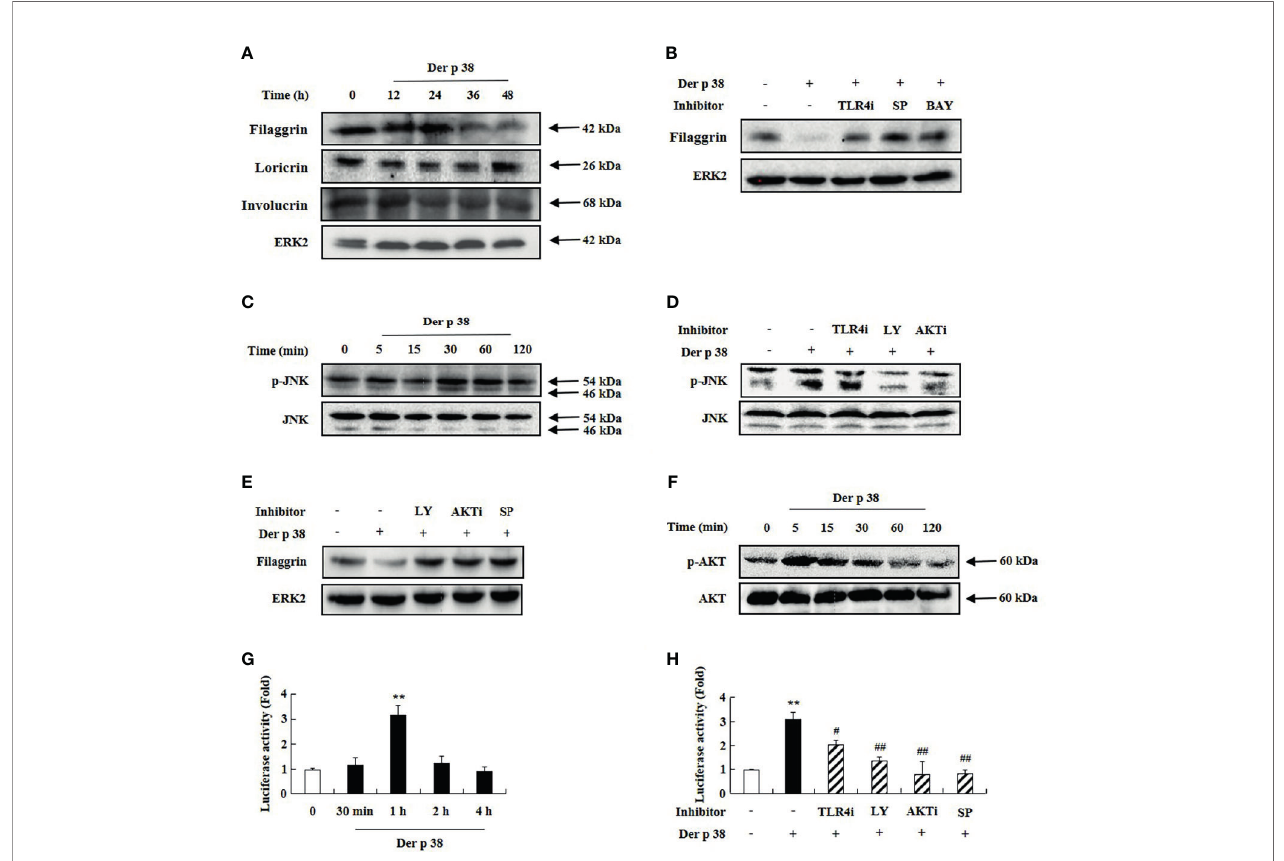
FIGURE 2 | Der p 38 diminishes fi laggrin expression via TLR4, PI3K, AKT, JNK and NF- k B inhuman keratinocyte HaCaT cells. (A, C, F) HaCaT cells were treated with 10 m g/mL Der p 38 for the indicated duration.The harvested cells were lysed, and fi laggrin,loricrin,involucrin (A) , phospho-JNK (C) , andphospho-AKT (F) were analyzed by Westernblotting. (B, D) The cells were pretreatedwith 2 m M TLR4i, 10 m M LY294002 (LY), 10 m M AKTi, 10 m M SP600125 (SP) or 10 m M BAY-11-7085 (BAY) for 1 h, following Der p 38 treatment for 48 h (B) or 30 min (D) . Filaggrinand phospho-JNK were analyzed by Westernblotting. (E) The cells were pretreatedwith 10 m M LY294002, 10 m M AKTi or 10 m M SP600125, after which they were treated with Der p 38 for 48 h.Filaggrin was analyzed by Westernblotting. ERK2 was used as an internal control. (G,H) The cells were treated with 10 m g/mLDer p 38 ina time dependent manner (G) , or10 m g/mL Der p 38 after pretreatment with 2 m M TLR4i,10 m M LY294002, 10 m M AKTi, or 10 m M SP600125 (H) . After lysis of the harvestedcells, NF- k B activity inthe lysates was evaluated bythe luciferase assay. The data are presented relative to the control,which was set at 1 as the mean ± S.D(n=3).** p < 0.01 indicates a signi fi cant difference between untreatedand Der p 38-treated groups, and # p < 0.05 and ## p < 0.01 indicate signi fi cant difference between the Der p 38-treated group andthe inhibitor-treated